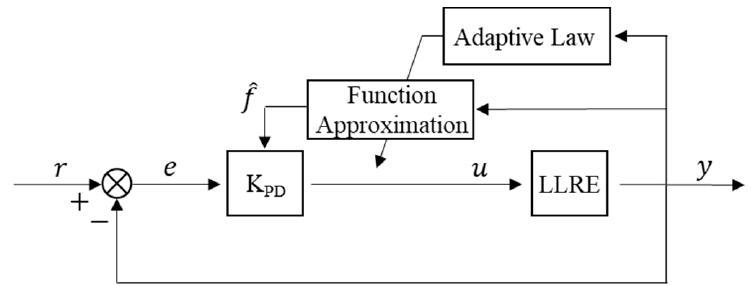
Figure 7. Adaptive PD RBFNN controller.